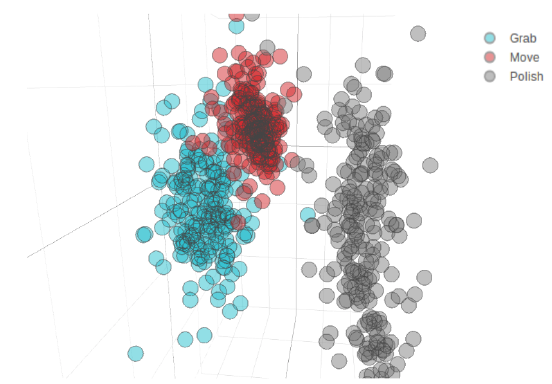
Figure 14. Normalized confusion matrix of the performance of the system during the validation with all users and trials. The matrix is non-symmetric, and the biggest portion of misclassified samples of the classes “grab” and “polish” are inferred as “move”, which indicates the existence of some bias in favor of the class “move”.